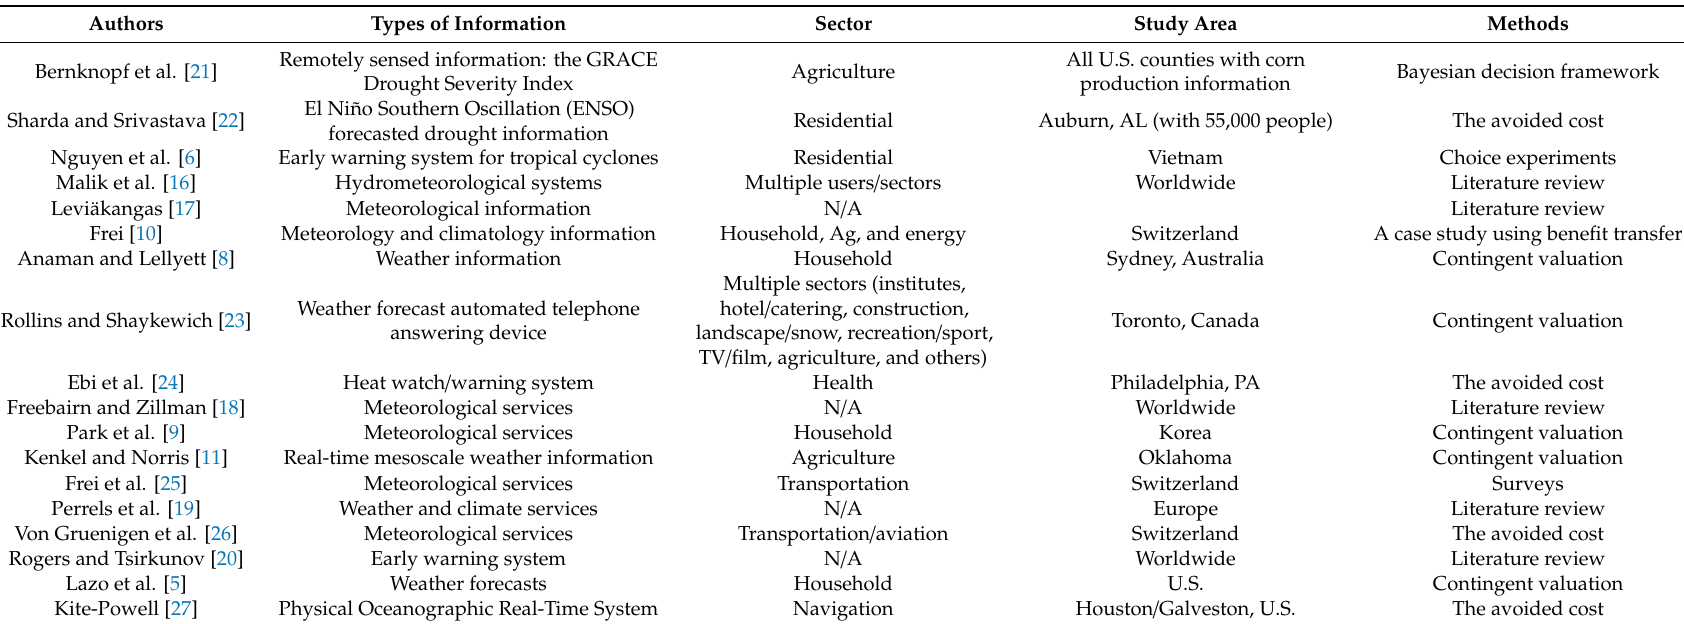
Table 1. Summary of the papers / reports examining the value of climatic and meteorological